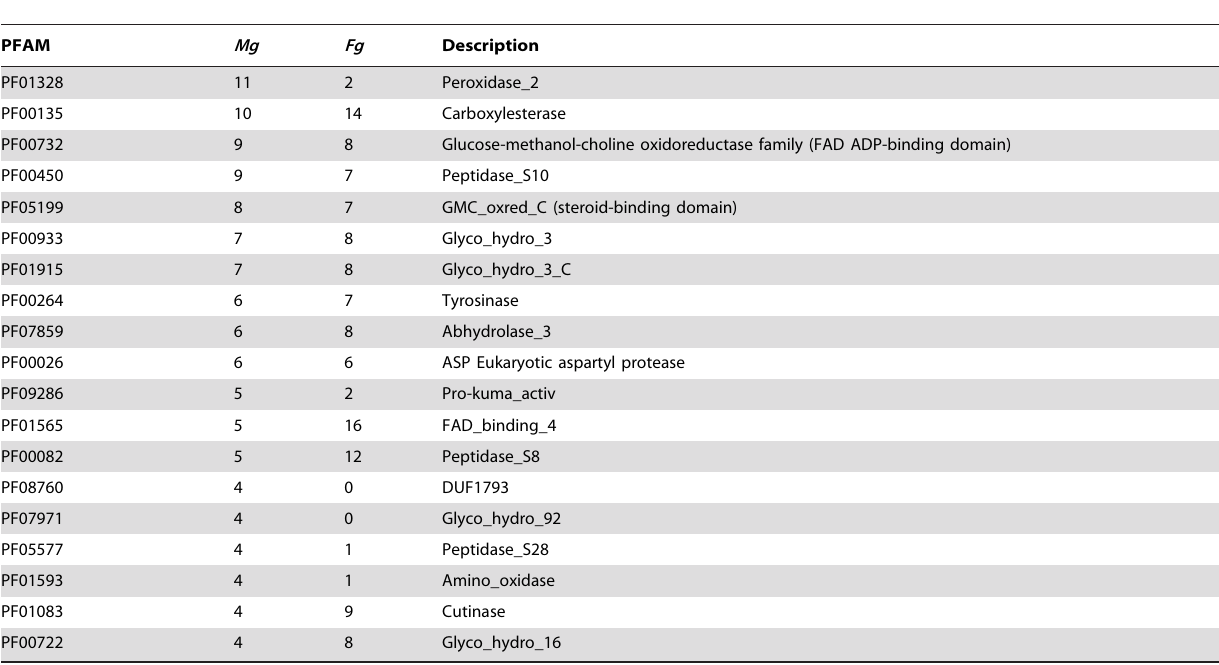
Table 6. Most frequent PFAM domains found throughout the secretome of Mycosphaerella graminicola ( Mg ), and corresponding frequency in Fusarium graminearum ( Fg